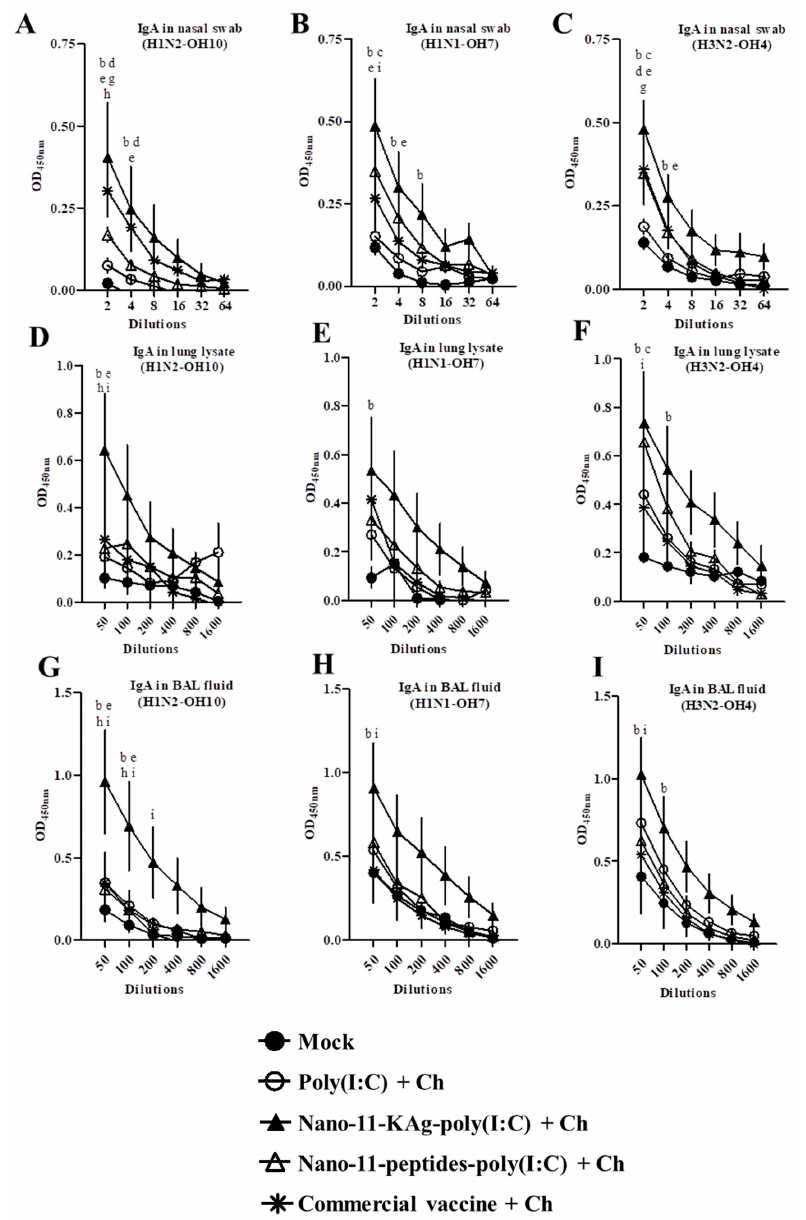
Figure 2. Poly(I:C) adjuvanted Nano-11-KAg vaccine induced increased cross-reactive SIgA antibody response. Pigs were vaccinated twice with poly(I:C) adjuvanted Nano-11-based vaccines (containing H1N2-OH10 virus or 10 peptides) or commercial vaccine (containing H1N1, H1N2 and H3N2 viruses) and challenged (H1N1-OH7 virus) at 35 days post prime vaccination. Samples collected at day six post-challenge were used for SIgA antibody analysis. Secretory IgA antibody response in nasal swab, lung lysate, and BAL fluid samples against ( A , D , G ) H1N2-OH10; ( B , E , H ) H1N1-OH7; and ( C , F , I ) H3N2-OH4 viruses were analyzed by ELISA. Data represent the mean value of four to five pigs ± SEM at all indicated dilutions. Statistical analysis was carried out using two-way ANOVA followed by a Bonferroni test. Each letter indicates the significant di ff erence between the groups at the indicated dilution. b, c, and d indicate the di ff erence between mock group compared to Nano-11-KAg-poly(I:C) + Ch, Nano-11-peptide-poly(I:C) + Ch, and Commercial vaccine + Ch, respectively. e and g indicate the di ff erence between poly(I:C) + Ch compared to Nano-11-KAg-poly(I:C) + Ch, and Commercial vaccine + Ch, respectively. h and i indicate the di ff erence between Nano-11-KAg-poly(I:C) + Ch compared to Nano-11-peptide-poly(I:C) + Ch and Commercial vaccine + Ch, respectively. A p < 0.05 was considered statistically significant.